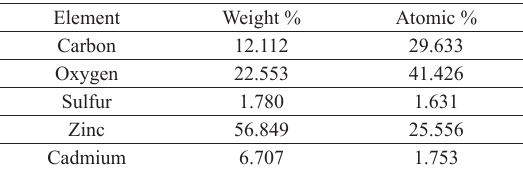
Figure 5. Elemental distribution of the material XC/ZnO-Zn f) Sulfur. Table 1. Atomic composition of the XC/ZnO-Zn